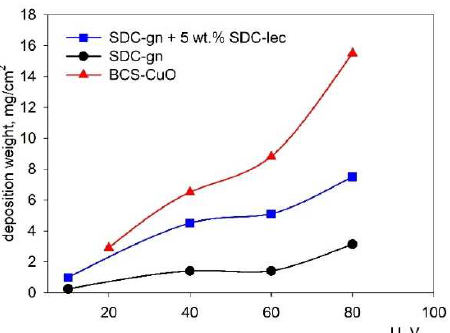
( b ) Figure 2. Change in the current strength with time during EPD on the Ni-foil model electrode: ( a ) for the suspensions of 10 g/L SDC-gn/lec and 10 g/L SDC-gn (V = 60 V, t = 6 min); ( b ) for the suspen- sion of 10 g/L BCS-CuO (V = 80 V, t = 10 min). The current strength behavior on time for the suspension of 10 g/L BCS-CuO (Figure